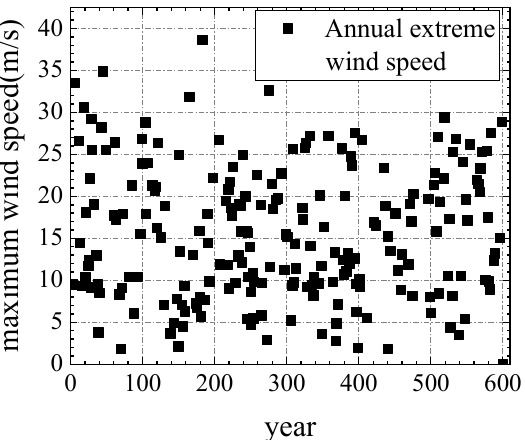
Figure 11. Flow chart of the full-track simulation of a single typhoon.